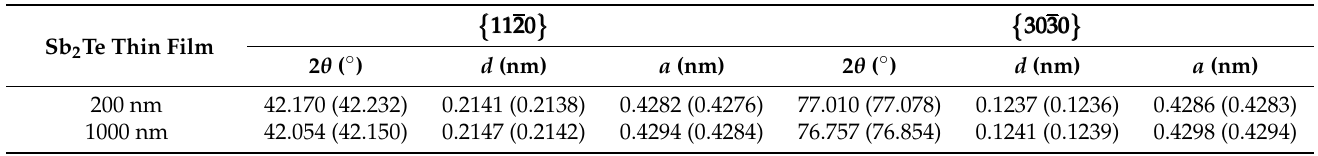
Table 3. Structural parameters (diffraction angle (2 θ ) and interplanar spacing ( d ) of (cid:8) (cid:9) 3030 planes and lattice parameter ( a )) of 200 nm and 1000 nm Sb 2 Te thin films annealed at 15 min and 35 min (shown in